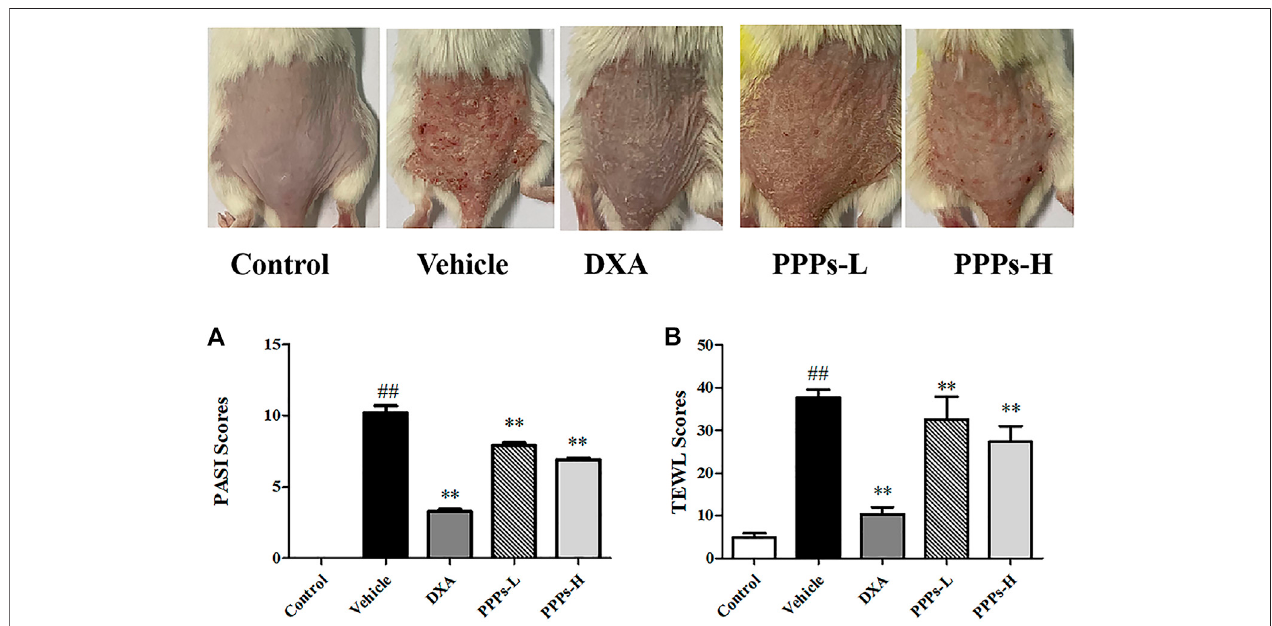
FIGURE 3 | Punica granatum peel polysaccharides (PPPs) ameliorated imiquimod (IMQ)-induced psoriasis in BALB/c mice. Representative photographs of the dorsalskinintheIMQ-elicitedpsoriasismousemodel post-IMQtreatmentwithoutorwithPPPs. (A) Psoriasis Areaand Severity Index(PASI) scoresoftheskinlesions in mice with IMQ-elicited psoriasis post-treatment. (B) Transepidermal water loss (TEWL) of the skin lesions in IMQ-induced psoriasis-like mice. Data are presented as the mean ± SD ( n (cid:1) 6). # p < 0.05, ## p < 0.01 vs . the control group; * p < 0.05, ** p < 0.01 vs . the vehicle group. PPPs-L , low-dose PPPs; PPPs-H , high-dose